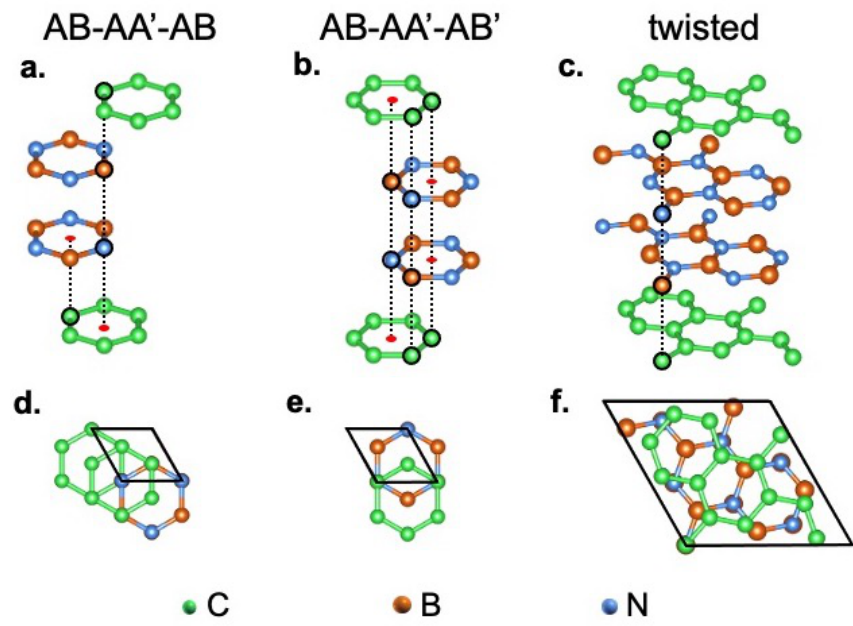
Figure 1. Crystal structures of C-BN-BN-C quadrilayers: ( a , d ) top and side view of AB-AA (cid:48) -AB stacking. ( b , e ) the same for AB-AA (cid:48) -AB (cid:48) stacking; ( c , f ) top and side view of the 21.8 ◦ twisted case T-AA (cid:48) -T. In the side views, the stacked atoms are circled in black, whereas the red dots indicate the vertical alignment of one atom in the upper layer with the center of the hexagon in the bottom layer. Our study reveals that AB stacking for C/BN interface and AA (cid:48) stacking for BN/BN interface are the most stable configurations. As shown in Table 1, C-BN interface in AB but to keep, as much as possible, high electronic carrier mobility values.[18–20] Due to stacking, with C on top of B, is more stable than AB (cid:48) , with C on top of N, by 24 meV/atom. ∼ The same analysis for BN interface shows that the AA (cid:48) is the more stable stacking. For what concerns the quadrilayers, in the first HT (AB-AA (cid:48) -AB, left panels of Figure 1), two completely equivalent C/BN (AB) interfaces are present, half of the carbon atoms of the top (bottom) graphene layer located above (below) boron atoms, and half at the center of h-BN hexagons. In the second one (AB-AA (cid:48) -AB (cid:48) , central panels of Figure 1), two non-equivalent C/BN interfaces occur, one AB (cid:48) (top) and the other AB (bottom): while, for the bottom graphene layer, the situation is similar to the previous case, for the top layer, half carbon atoms are located above the nitrogen atoms and half at the centers of hexagonal h-BN